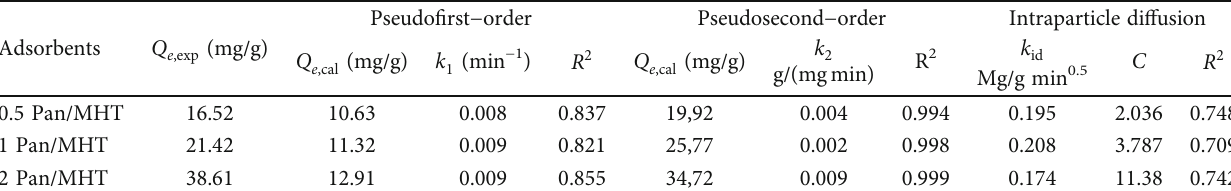
Figure 10: MO adsorption kinetics by 0.5 Pan/MHT, 1 Pan/MHT, and 2 Pan/MHT adsorbents. Pseudo fi rst − order model (a), pseudosecond − order model (b), and intraparticle di ff usion model (c). Table 2: Kinetic parameters of MO adsorption on Pan/MHT